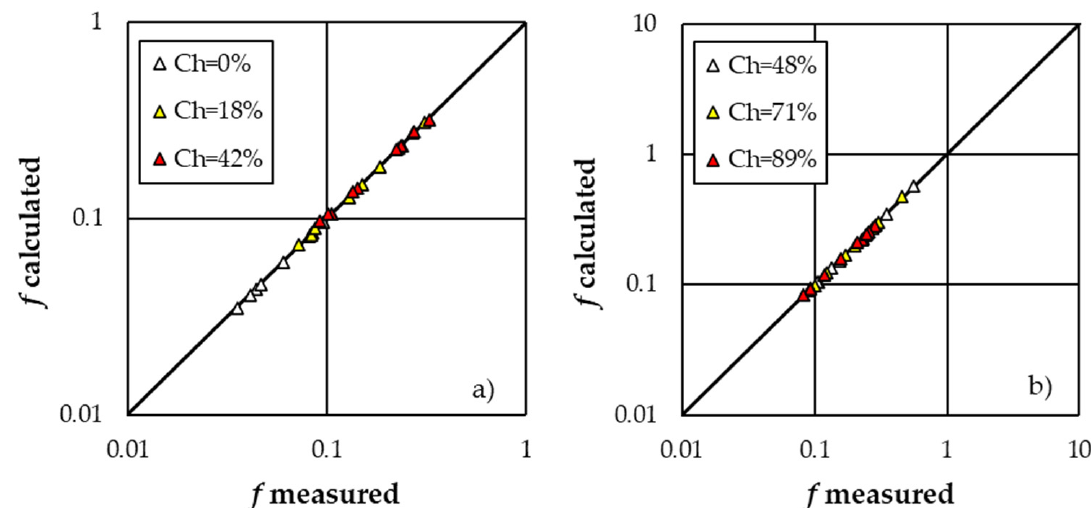
Figure 7. Trend of the Darcy–Weisbach friction factor for three selected values of concentration for low ( Ch = 0, 18, and 42%) ( a ) and high ( Ch = 48, 71, and 89%) ( b ) values of roughness concentration. For Ch < 48%, since Equations (8a), (10a), and (12) presented similar values of the b and c coefficients, their mean values ( b = 1.078 and c = 0.58) can be used to attribute to